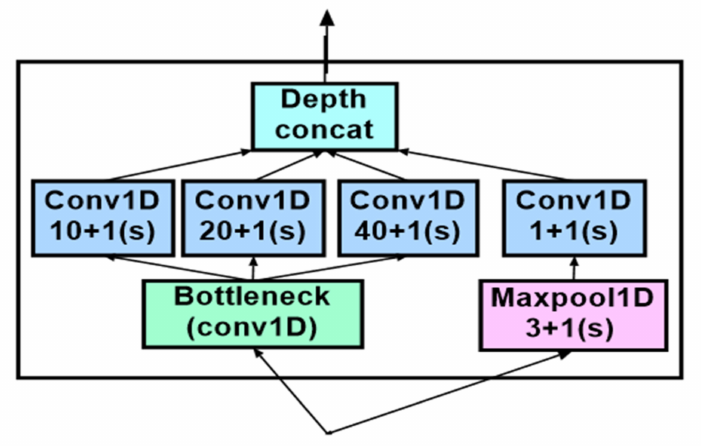
Figure 3. The Inception Time model. The first number in each box represents the kernel size, while the second represents the stride size; (s) indicates the padding type.